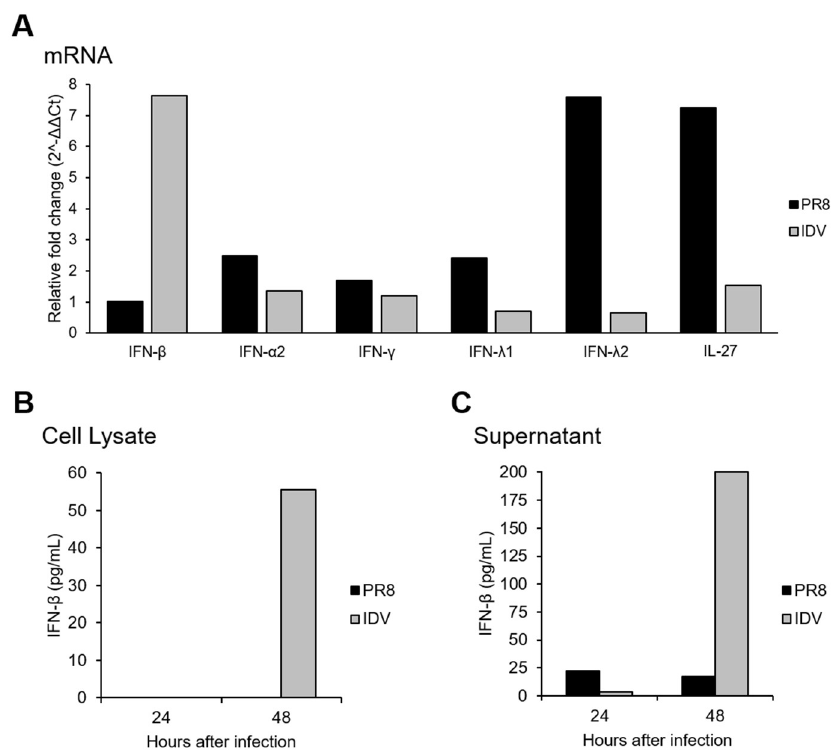
Figure 5. Interferon analysis of infected A549 cells by RT-qPCR and ELISA. ( A ) RNA from PR8-infected (black bars) or OK11-infected (IDV; grey bars) A549 cells was analyzed for interferon (IFN) mRNA transcript using RT-qPCR (Thermo Fisher). Fold change in transcript levels was calculated using the 2 - ∆∆ Ct method [33] so that data are normalized to both the uninfected control and the housekeeping gene 18S rRNA. Values represent results from three independent experiments. Cell lysates ( B ) and supernatants ( C ) of PR8- or OK11-infected A549 cells were analyzed for IFN- β protein production by ELISA (PBL Assay Science) and corrected for background expression using uninfected controls. Values are from a single experiment, with both cell lysates and supernatants represented.